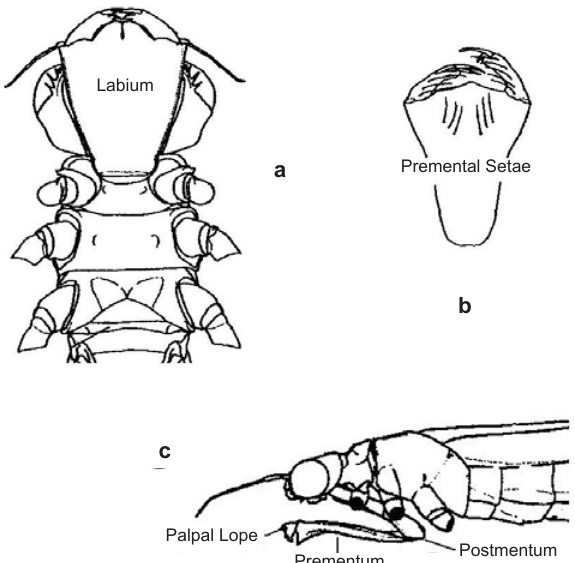
Figure 2. Taxa Tolerance scores of macroinvertebrates in HKHbios Scoring list (Ofenböck et al. 2010) for different taxonomic groups. HKHbios list consists of 139 families from different taxonomic groups for Hindu Kush Himalaya.